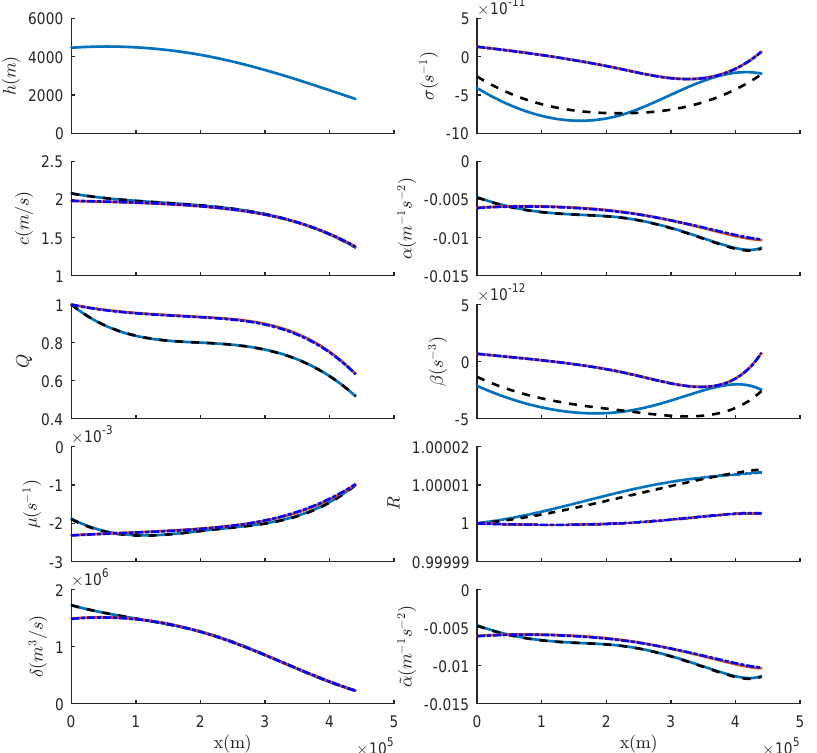
Figure 3. Variation of the original coefficients (left panel and top of the right panel) and the derived coefficients (remainder of the right panel) of the vKdV equation for conditions of the Western Portugal case. The results show the coefficients in summer with background current u 0 (blue, solid), without u 0 (black, dash) and the coefficients in winter with u 0 (red, solid), without u 0 (blue,